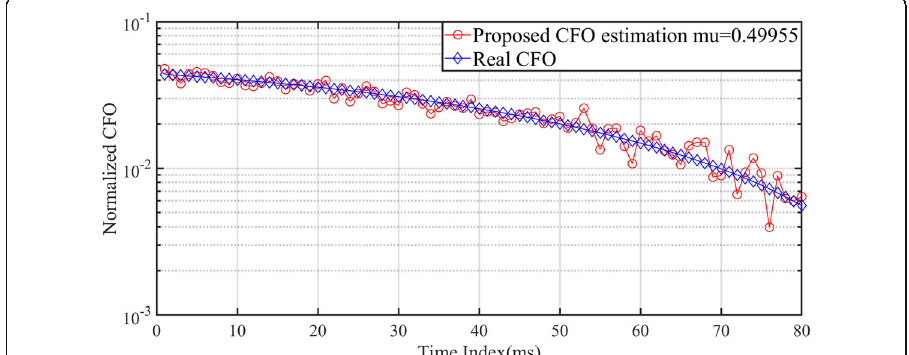
Fig. 17 Normalized real CFO vs. the estimated CFO for the time-varying